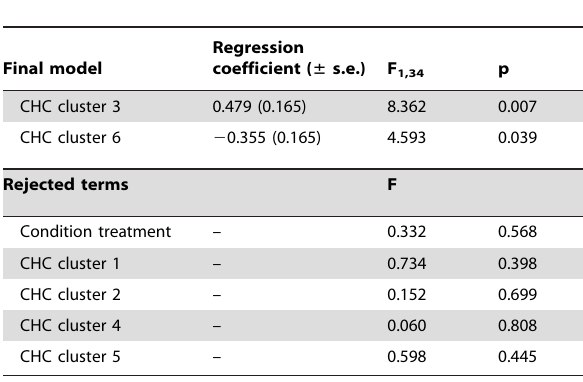
Table 3. Relationship between hatching date dependent nymph survival and female